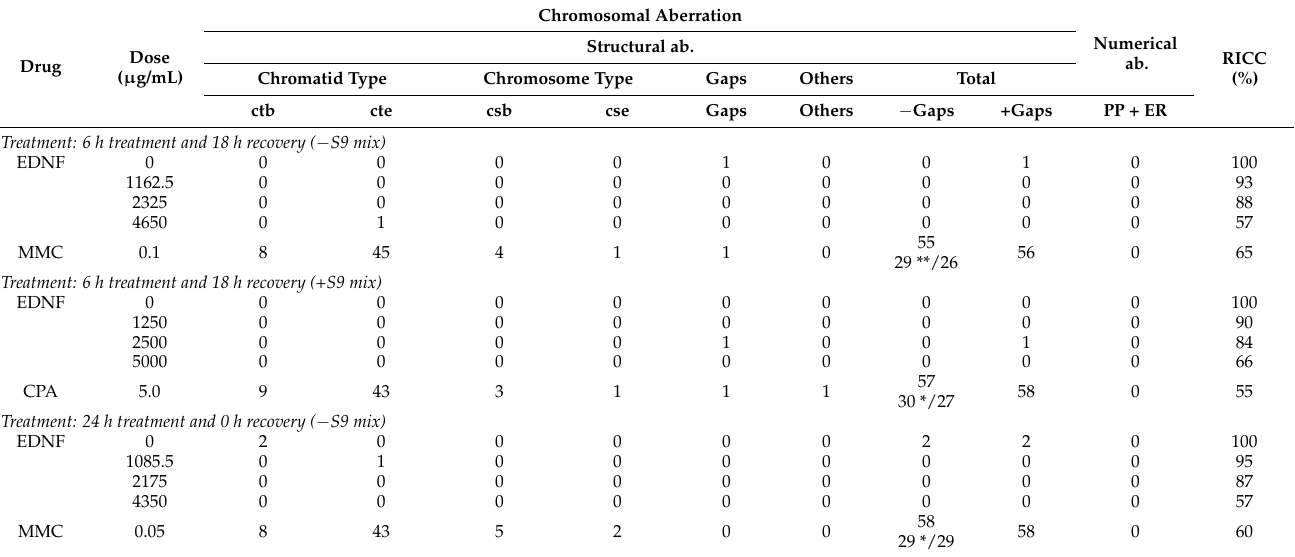
Table 3. Results of the chromosomal aberration test of aqueous extract of dried noni fruits (EDNF).